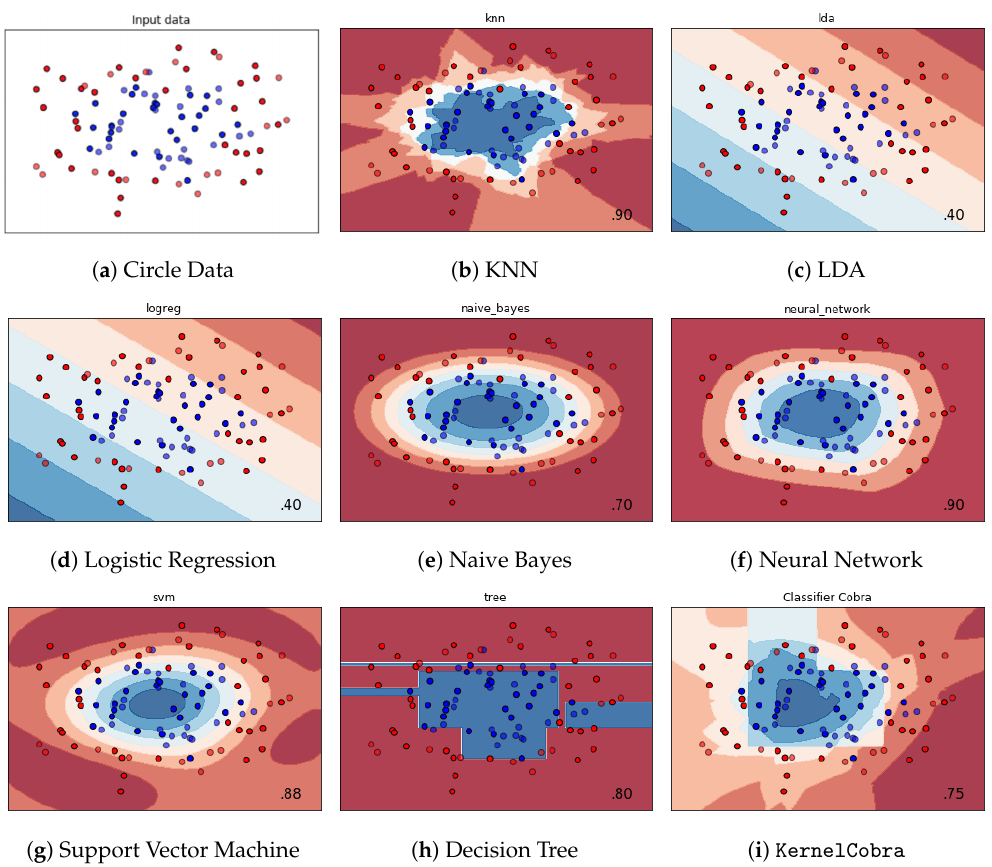
Figure 3. Decision boundaries of base classifiers and KernelCobra on the circle